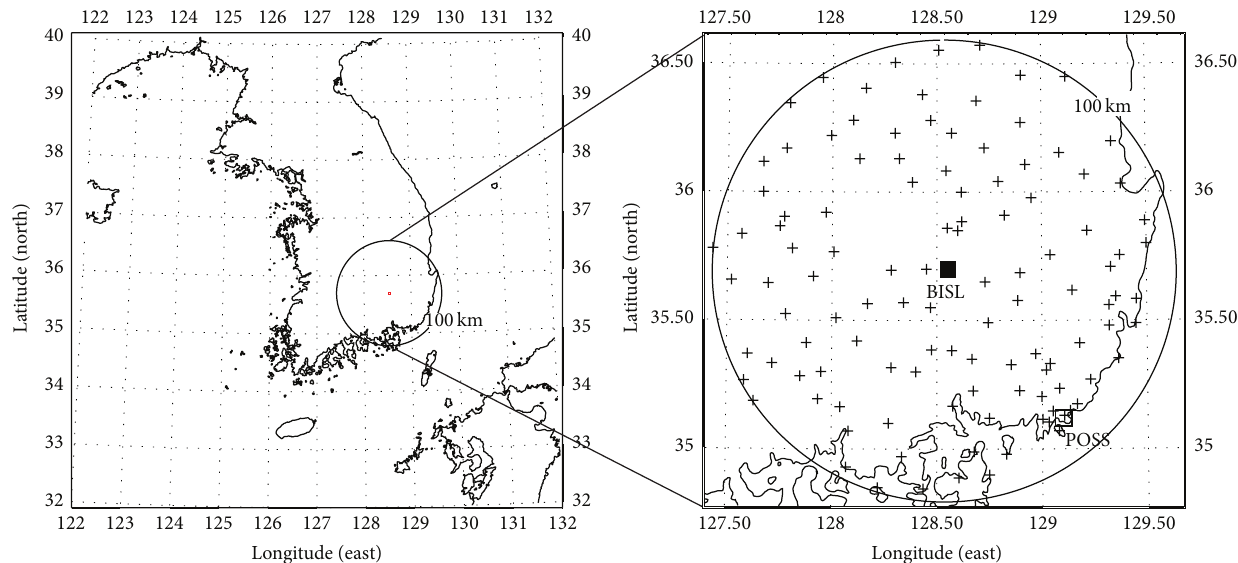
Figure 1: The location of a Bislsan radar (solid rectangle), a POSS disdrometer (open rectangle), and rain gages (plus sign) distributed within 100km of radar